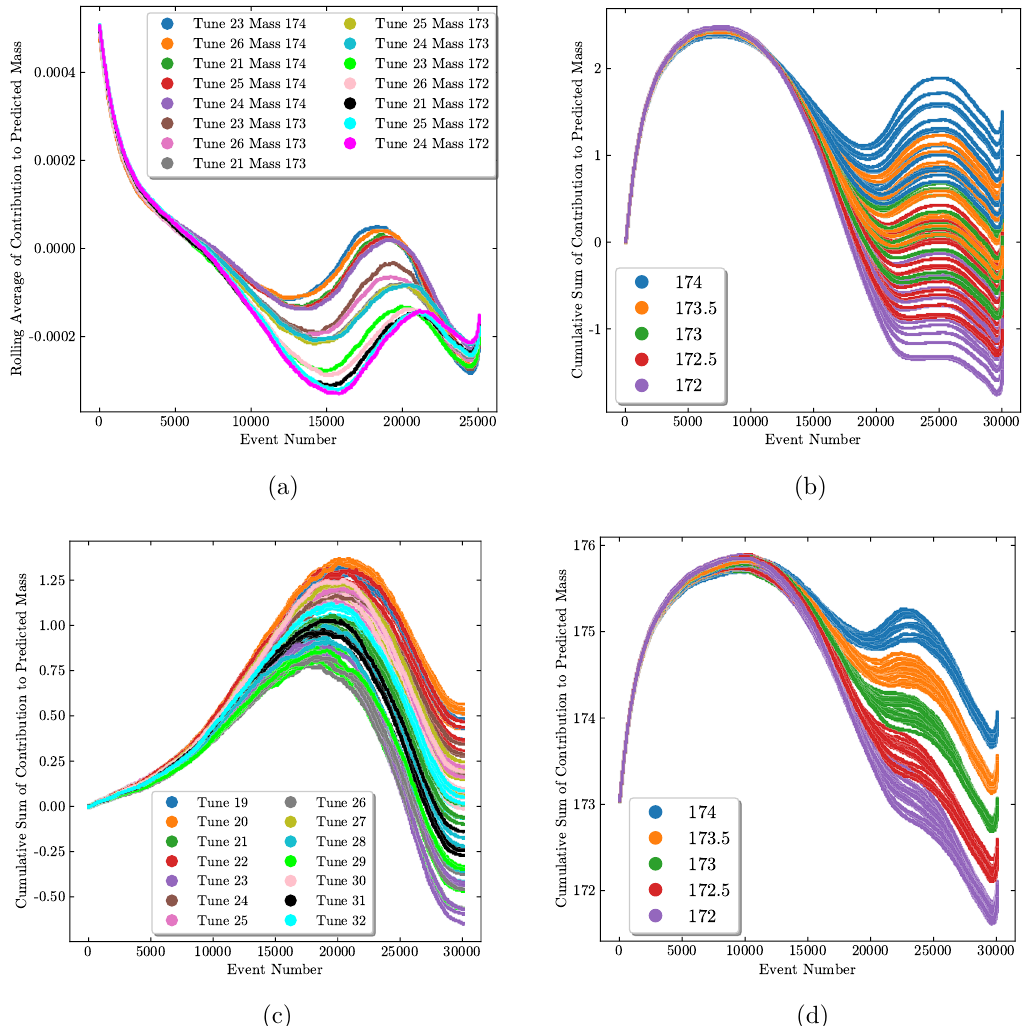
Figure 7. Graphical representations of the contribution to the predicted mass as a function of entry number in the ensemble using the m 3 j & m 2 j network. In (a), we show a rolling average of the product of the (normalized) m 3 j input multiplied by the network weight for each event number. Each color denotes a different mass and tune. Only a subset of masses and tunes have been shown for clarity. In (b)-(d), each point is the cumulative sum up to that event number of the (normalized) input value multiplied by the network weight. (b) includes only the m 3 j contribution, with colors denoting masses and each mass including 1 sample from each of the A14 tunes. (c) includes only the m 2 j contribution, with colors denoting tunes. One sample at each mass is included for each tune. (d) sums over both m 3 j and m 2 j with colors again denoting masses. The bias is included in the zeroth